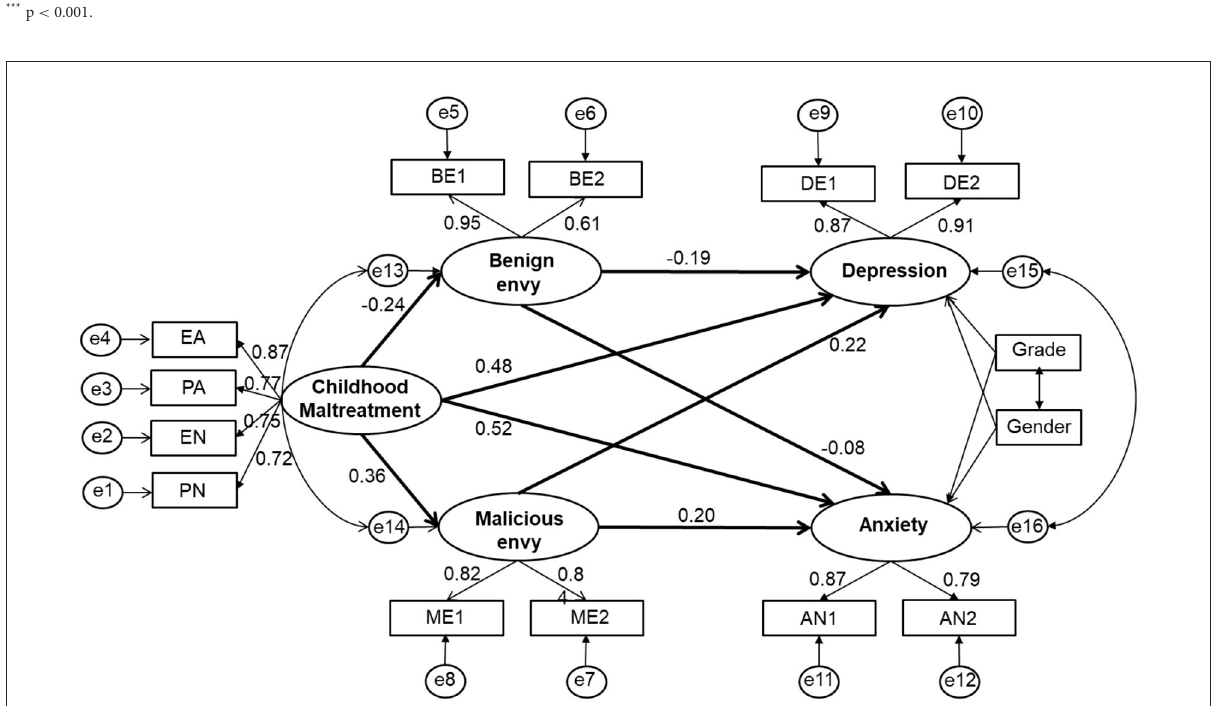
FIGURE1 The mediation model. Factor loadings are standardized. EA, PA, EN, PN are the four observed variables of childhood maltreatment (CM). BE1 and BE2 are the two observation variables of benign envy (BE), and ME1 and ME2 are the two observed variables of malicious envy (ME). DE1 and DE2 are the two observed variables of depression (DE), and AN1 and AN2 are the two observed variables of anxiety (AN).